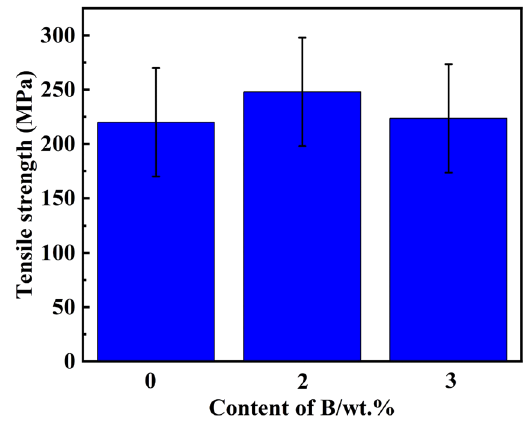
Figure 13: Tensile strength of brazed joints.